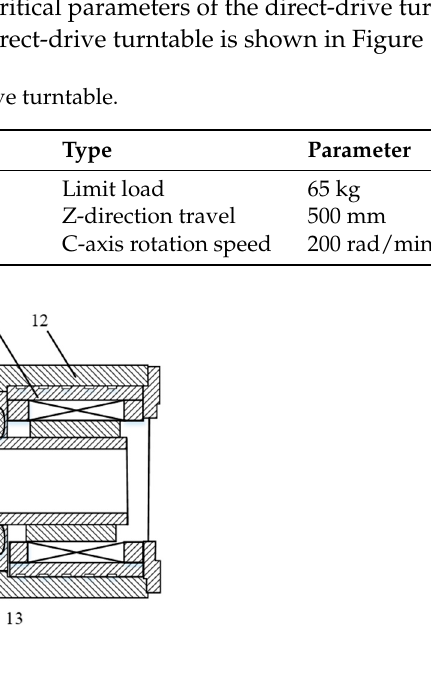
Figure 1. Structure of direct-drive turntable: 1—protective box, 2—C-axis torque motor, 3—pneumatic clamping mechanism, 4—C-axis mounting sleeve, 5—turntable bearing, 6—C-axis rotating spindle, 7—turntable surface, 8—swing frame, 9—A-axis rotating spindle, 10—pneumatic clamping mecha- nism 2, 11—A-axis torque motor, 12—A-axis mounting sleeve, and 13—turntable bearing